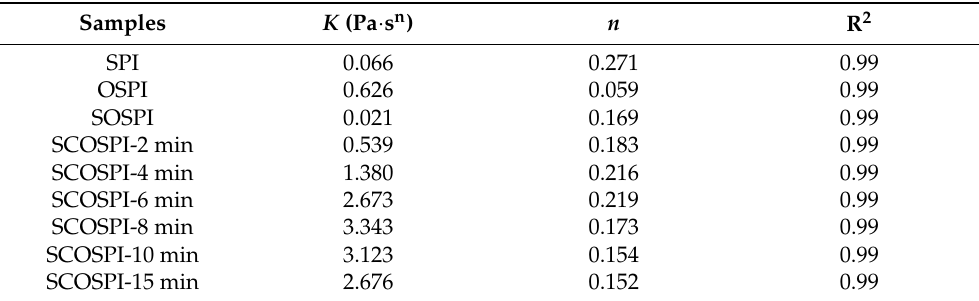
Figure 10. Apparent viscosity and shear rate relationship of emulsions of natural, oxidized soybean protein, and cavitation jet treated on soluble soybean protein oxidized accumulates at several times (2, 4, 6, 8, 10, and 15 min). Table 5. Fitting result of Sisko’s model of emulsion of natural, oxidized soybean protein, and cavitation jet treated on soluble soybean protein oxidized accumulates at several times (2, 4, 6, 8, 10, and 15 min).